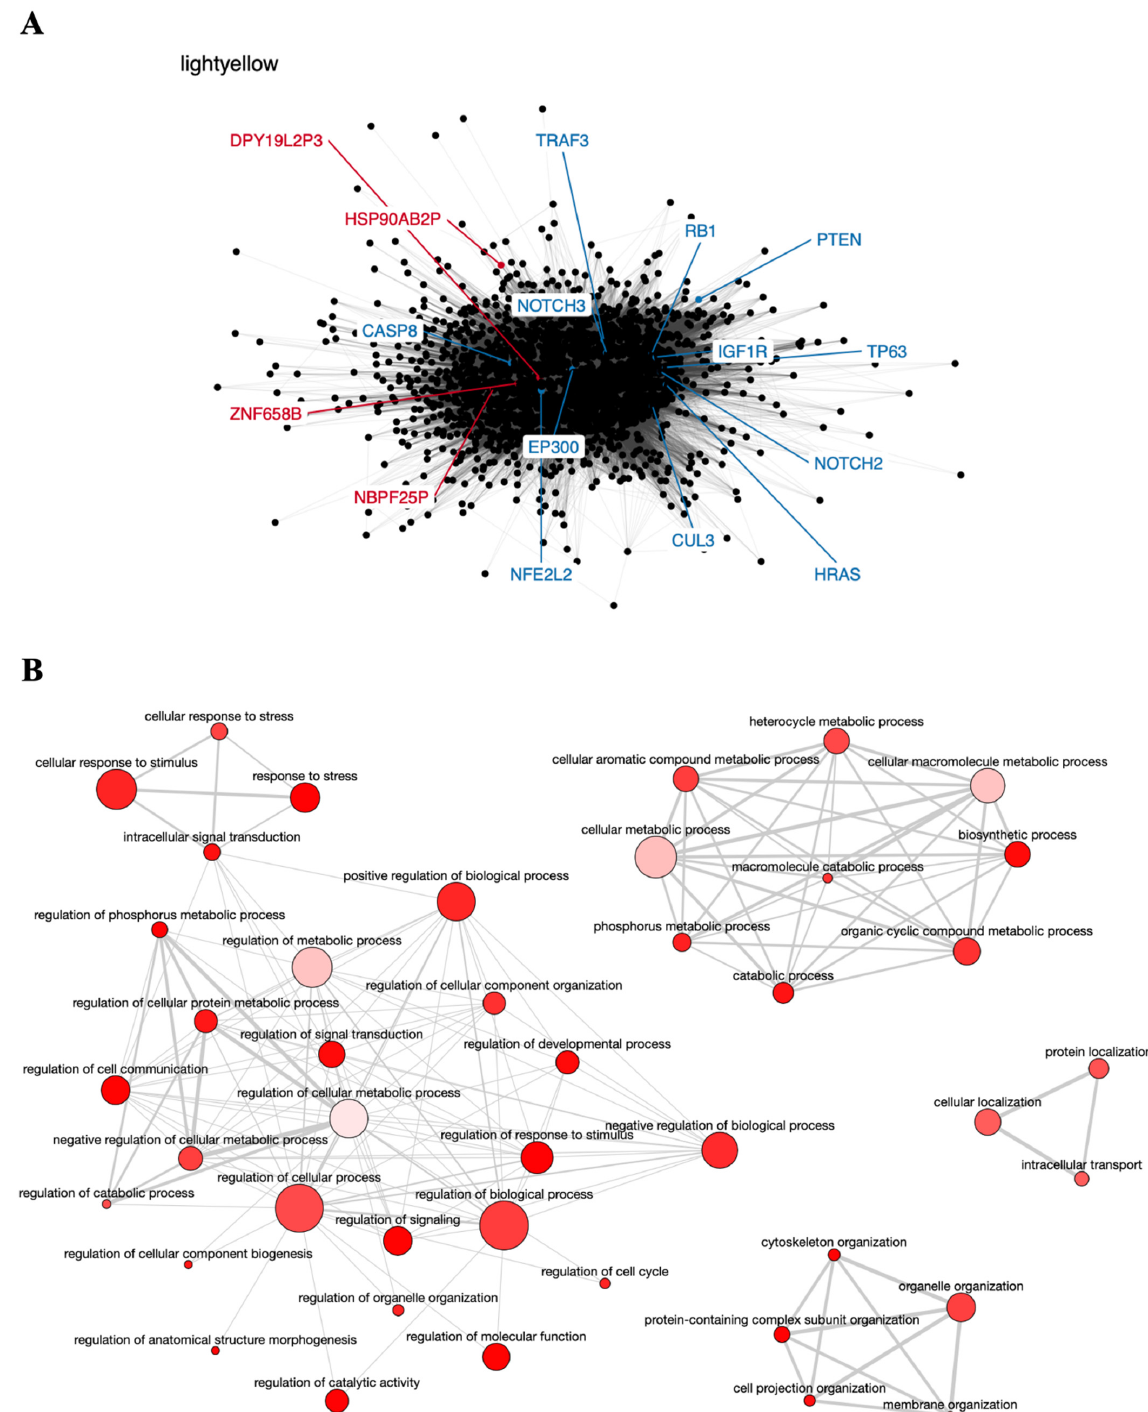
Figure 2. Co-expression network and GO enrichment analysis. Light-yellow module containing NBPF25P, HSP90AB2P , ZNF658B and DPY19L2P3 pseudogenes from co-expression network of 213 head and neck cancer (HNC) patients and gene ontology (GO) enrichment analysis. ( A ) Network highlighting pseudogenes (red letter) and HNC-related genes (blue letter) constructed using the Weighted Correlation Network Analysis (WGCNA) R software package. ( B ) Enriched GO terms identified by GOATOOLS Python library and summarized by the web tool REVIGO. Circles colored with darker red indicate GO terms with lower p -values in our enrichment analysis, while the size of the circles indicates the frequency of a GO term in the GO annotation database. GO terms that are highly similar have thicker